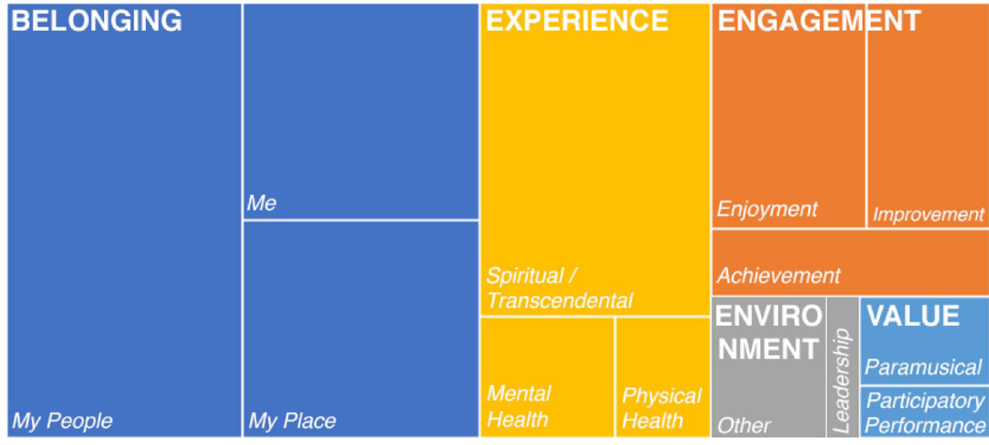
Fig. 6 Layer 1 coding density summary: Fellowship.